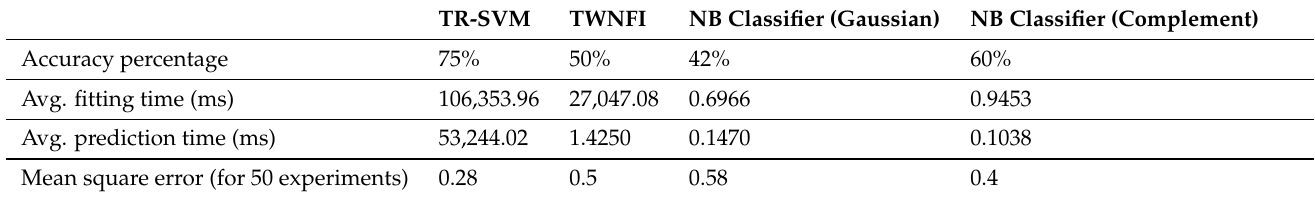
Table 1. Comparison of chosen machine learning algorithms for 100 samples.